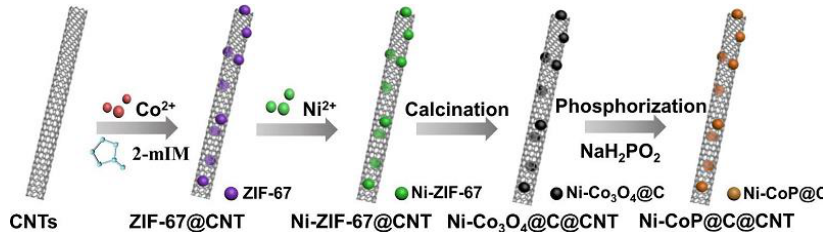
Figure 7. Schematic illustration of the fabrication process of Ni-CoP@C@CNT. Reproduced with permission from Reference [112]. Elsevier, 2020.